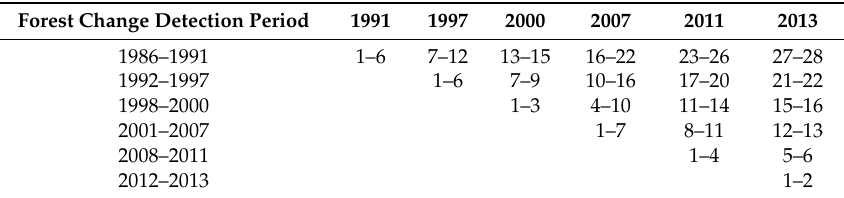
Table 5. Forest age computed for the time series dataset since 1985/1986. Forest age classes show different age per period due to different time period